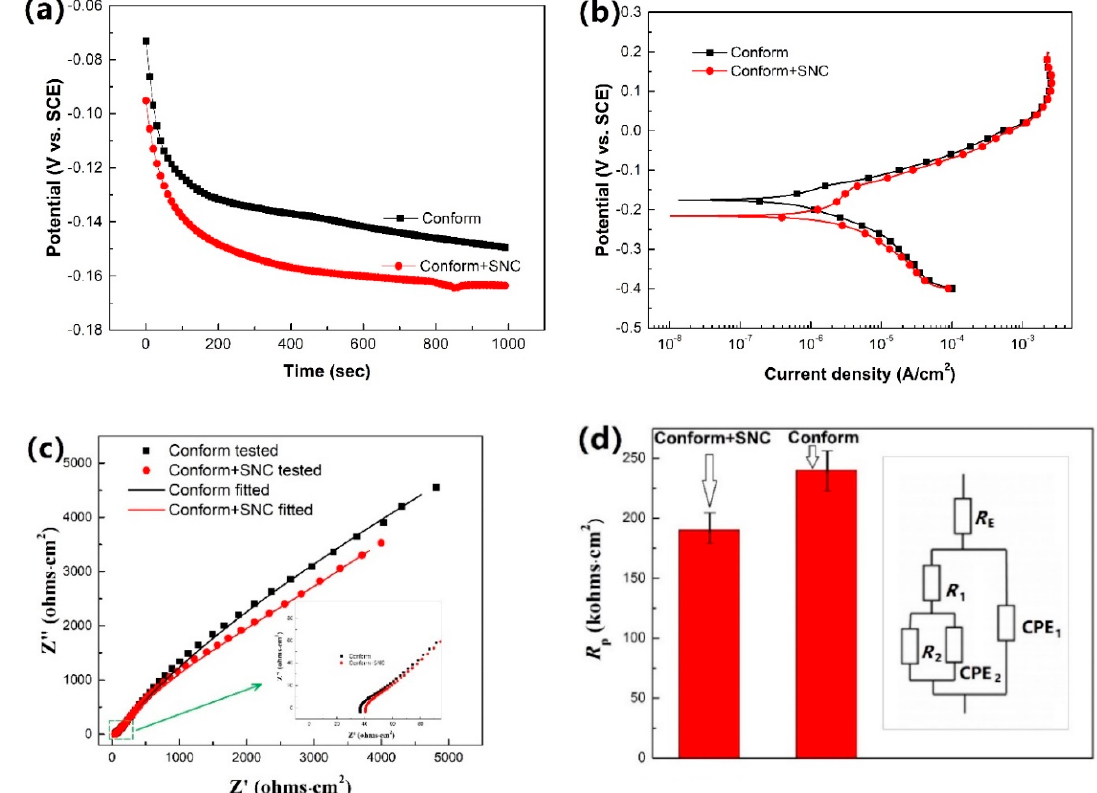
Figure 5. Electrochemical corrosion tests of the conform and conform + SNC Cu-Mg alloy after immersion in 0.1 M NaCl solution for 1000 s. ( a ) Open circuit potential (OCP) curves; ( b ) polarization curves; ( c ) and ( d ) are the EIS Nyquist plots and the relative equivalent circuit and fitted R p values.